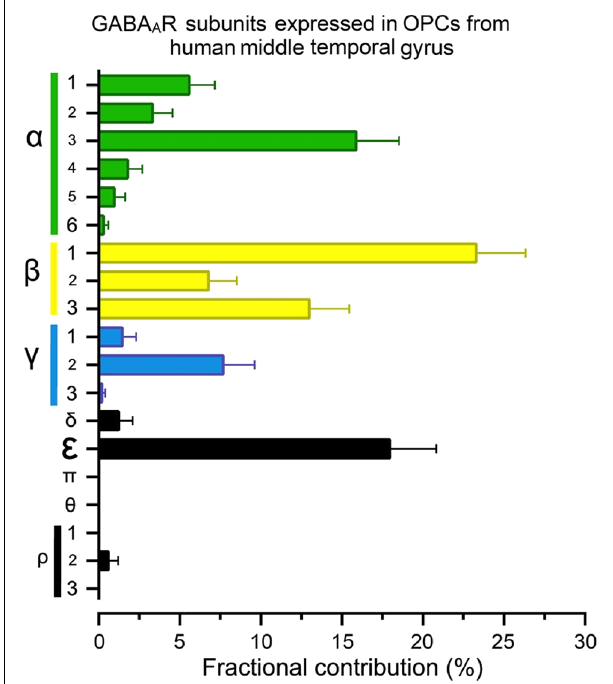
FIGURE 2 | The fractional contribution (FC) of GABA A R subunits in human oligodendrocyte progenitor cells (OPCs). Normalized gene expression levels for all 19 GABA A R subunits expressed as a percentage (mean ± S.E.M.) of the total available pool of mRNA for GABA A Rs in OPCs (PDGFR α + cells) from human brains, estimated from publicly available datasets (Hodge et al., 2019; https://celltypes.brain-map.org/rnaseq). The single-nucleus analysis used normalized RNA-Seq datasets from the middle temporal gyrus isolated from six subjects with no known neuropsychiatry or neuropathological history (three males and three females; 35–66 years old). Gene expression level in each dataset was transformed into FC (Sequeira et al., 2019). FC is defined as the percentage of the expression level of each subunit gene (signaled in the “y” axis) to the sum of the 19 genes for GABA A Rs subunits within each human/cell. Detailed demographic characteristics, as well as technical white papers for data processing and quality control, can be downloaded from the same site. Confirmatory analysis of OPC markers enrichment and lack of neuronal markers were performed for all